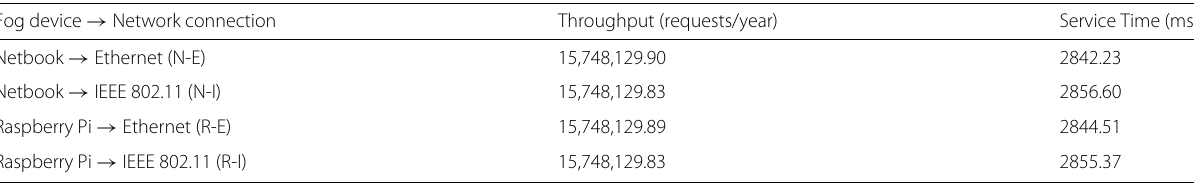
Table 11 Performance results of scenario 3 Fog device → Network